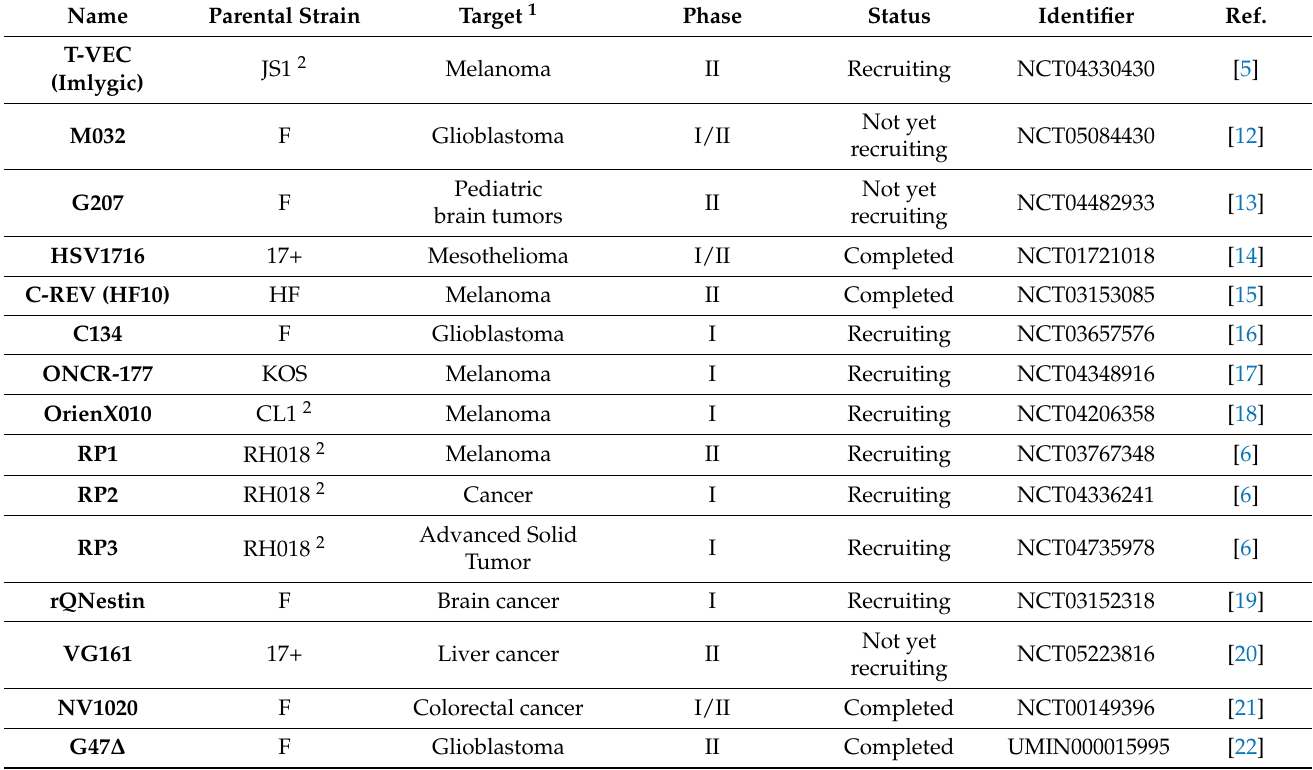
Table 1. Examples of oncolytic herpes simplex viruses (oHSVs) in recent or current clinical trials. As of 8 March 2022. For an expanded table with more comprehensive information, please see Supplementary Table